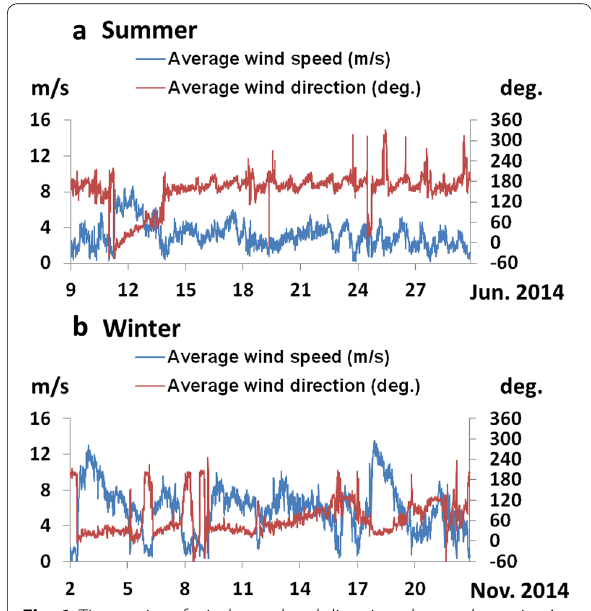
Fig. 6 Time series of wind speed and direction observed at point